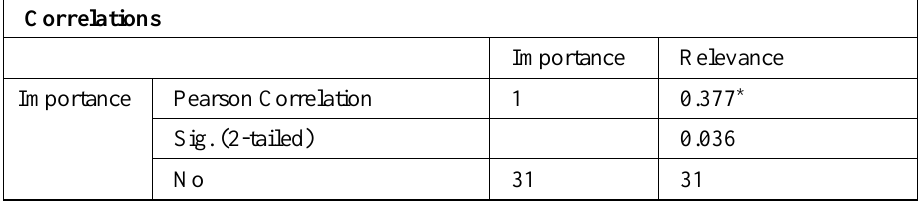
Table 10. The relationship between the importance of the audit findings and its relevance [Table and calculations made by